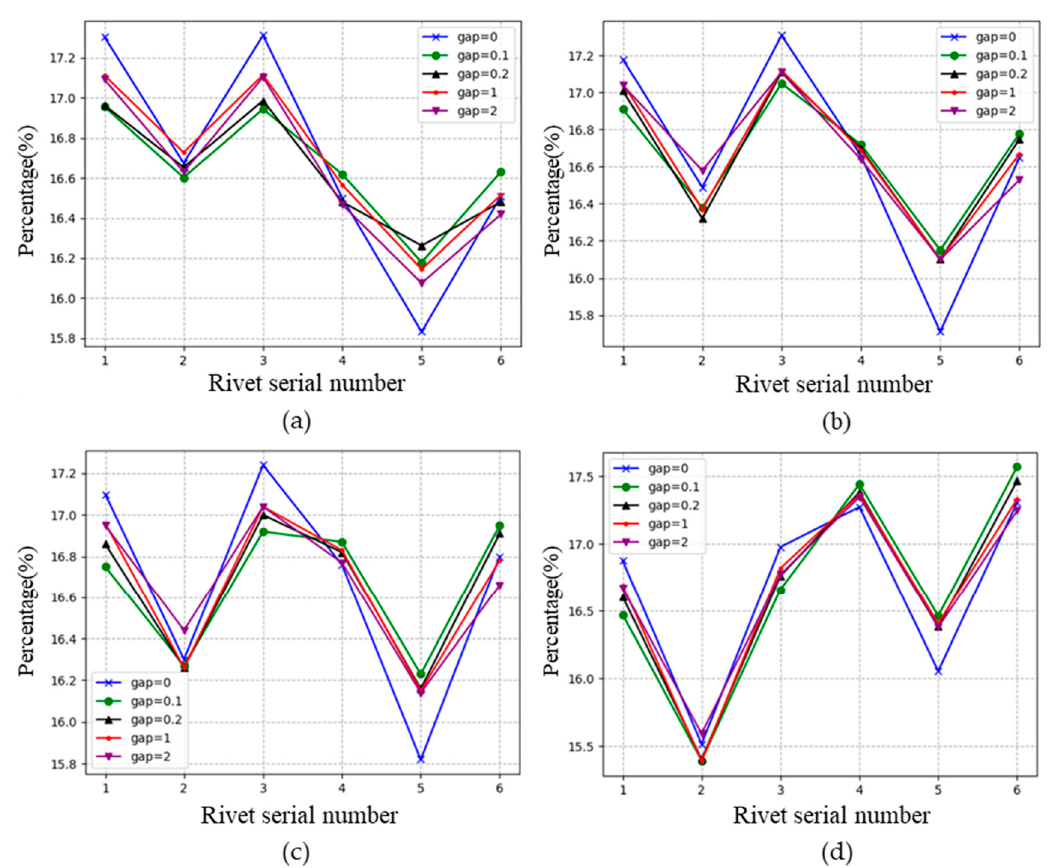
Figure 17. Distribution of rivet loads under different tensile loads: ( a ) Tensile load on 1 KN; ( b ) Tensile load on 3 KN; ( c ) Tensile load on 10 KN; ( d ) Tensile load on 25 KN. (Units of gap: mm).